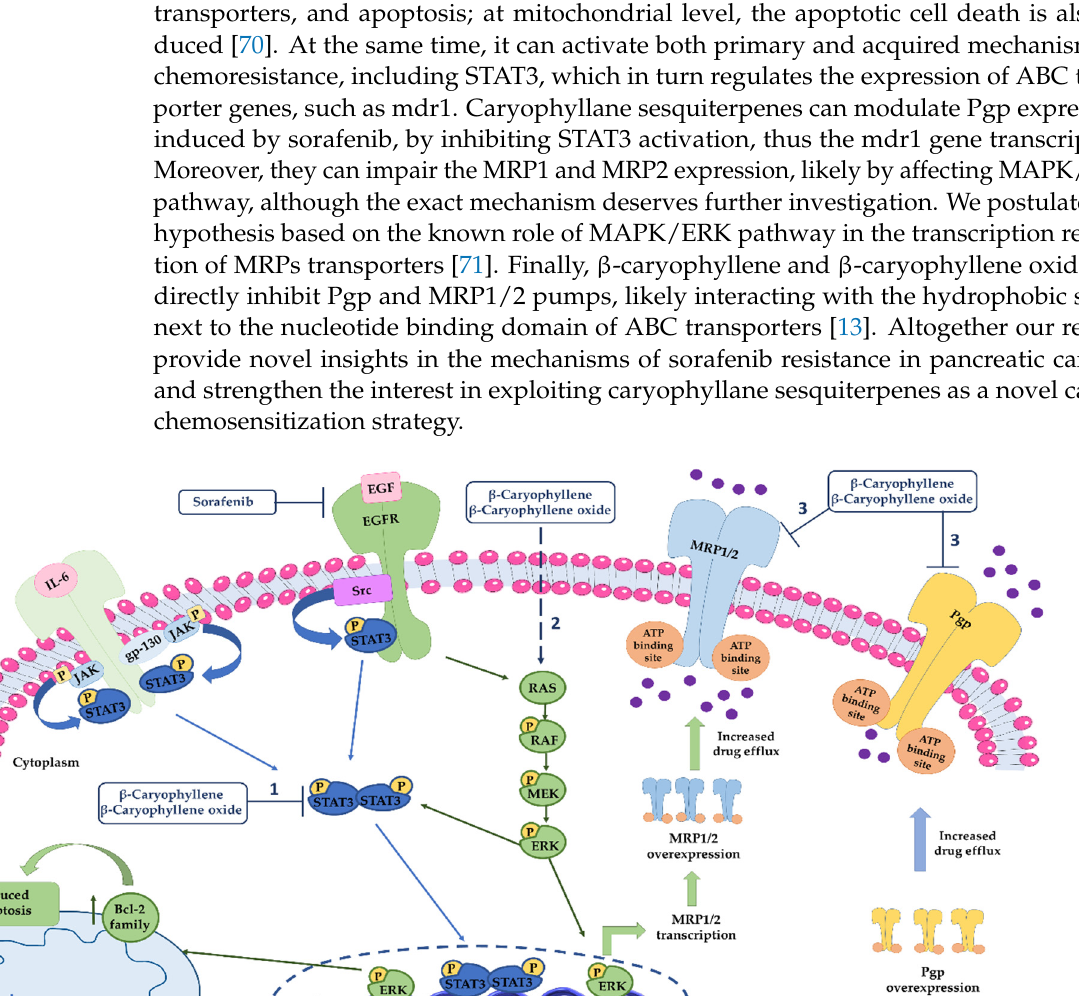
image of western blotting analysis regarding total STAT3 (membrane